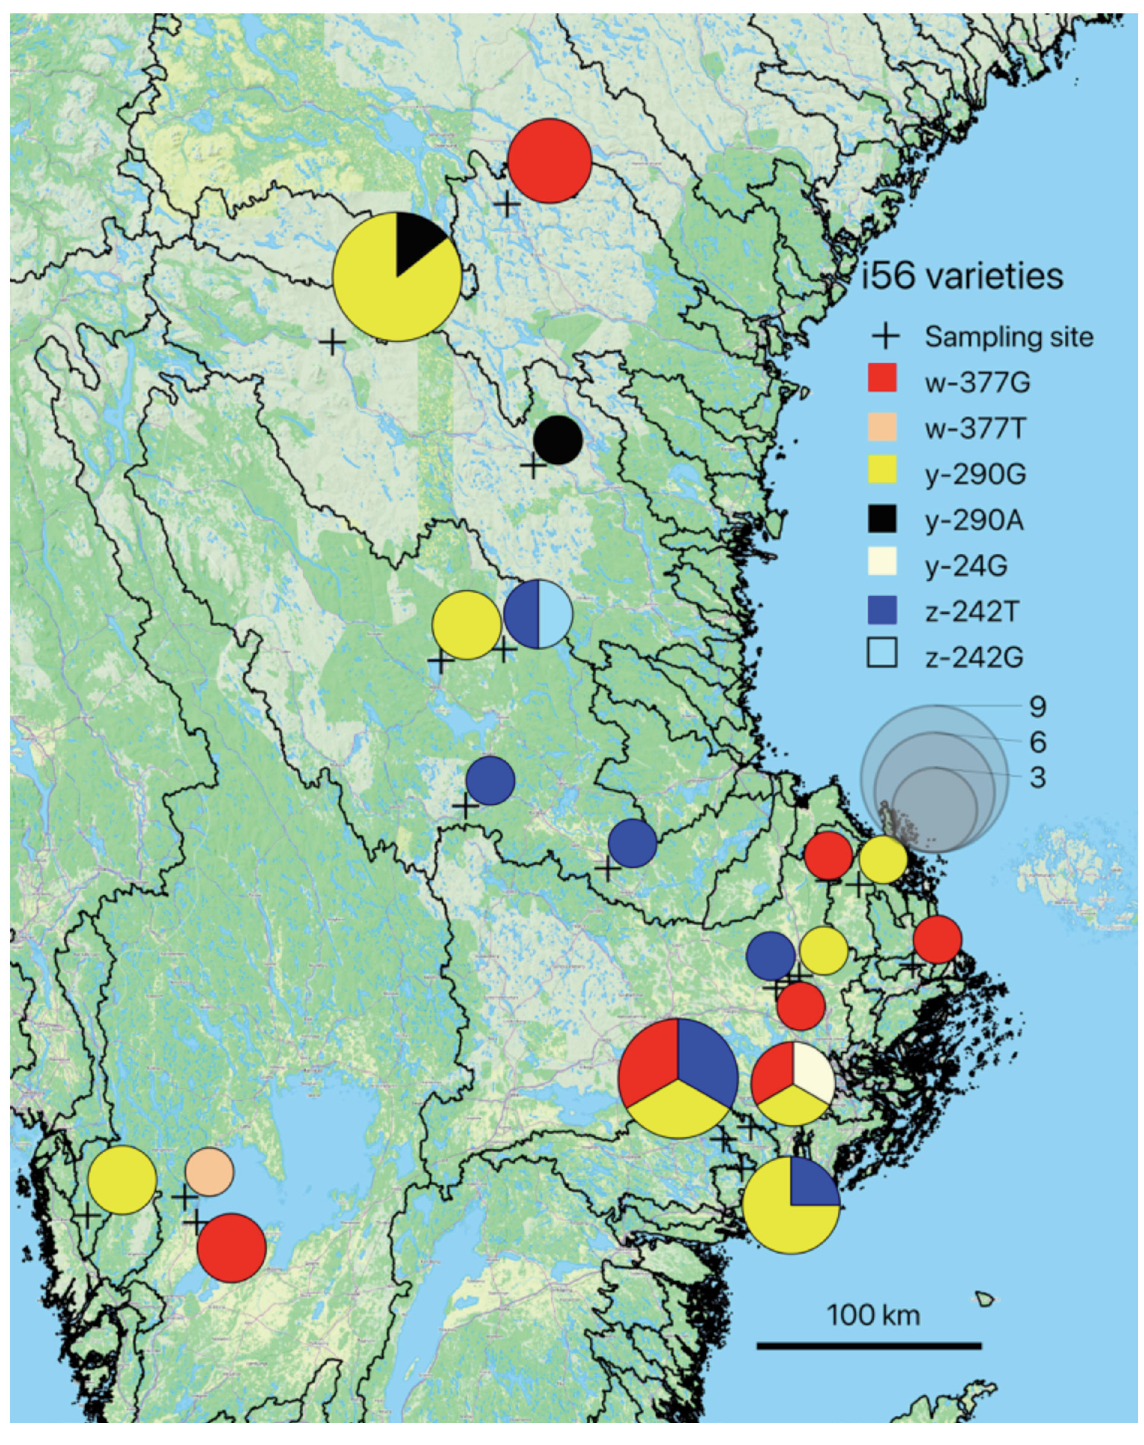
Fig. 8. Presence of i56 sequence varieties in Spongilla lacustris (Linnaeus, 1759) at different collecting sites. Black lines on the map represent watersheds between the catchment areas and cross hairs mark the actual sampling site. Seven sequence varieties were found, designated z-242T, z-242G, y-290G, y-290A, y-24G, w-377G and w-377T. Pie charts indicate fraction of the varieties at a site, and circle area corresponds to number of specimens sequenced from the